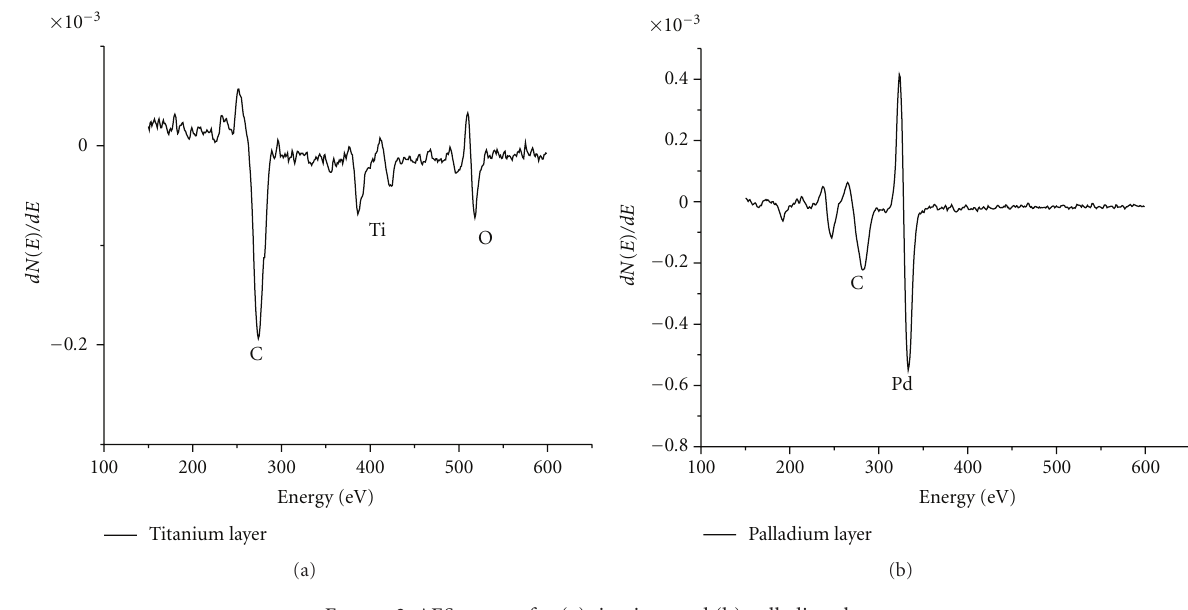
Figure 2: AES spectra for (a) titanium and (b) palladium layer.